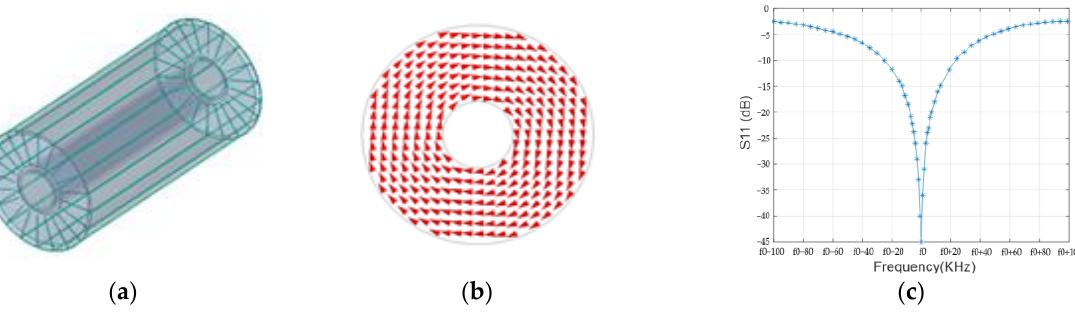
Figure 8. Coaxial cavity HFSS model ( a ), cross sectional magnetic field distribution ( b ) and S 11 of resonant cavity ( c ).